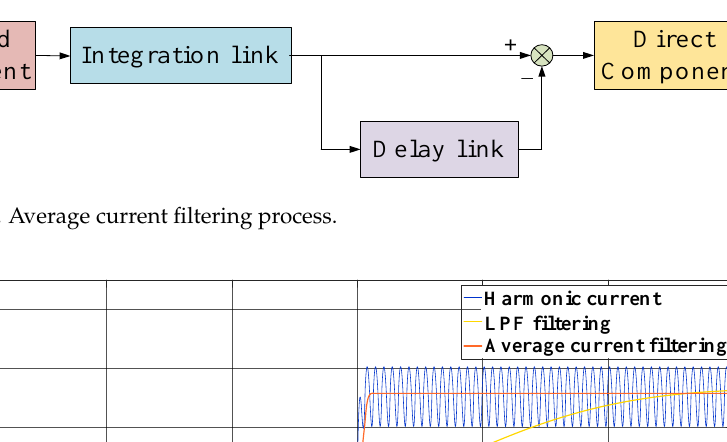
Figure 7. Average current filtering process.